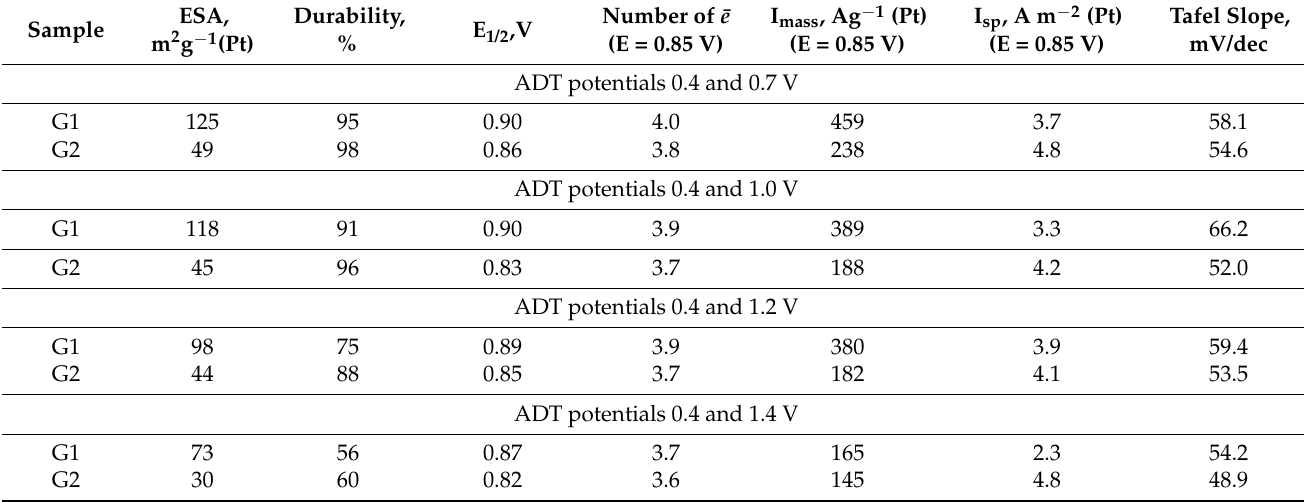
Table 2. Characteristics of Pt/C catalysts after ADT in different potential